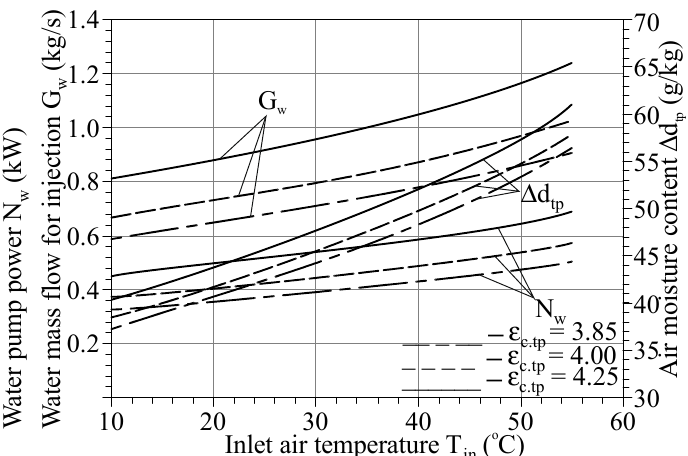
Figure 21. Dependences of the water pump power, N w ; the water mass flow for injection in the thermopressor, G w ; an increase in the air moisture content, Δ d tp , at different total pressure increase, ε c . tp , on the inlet air temperature, T in .